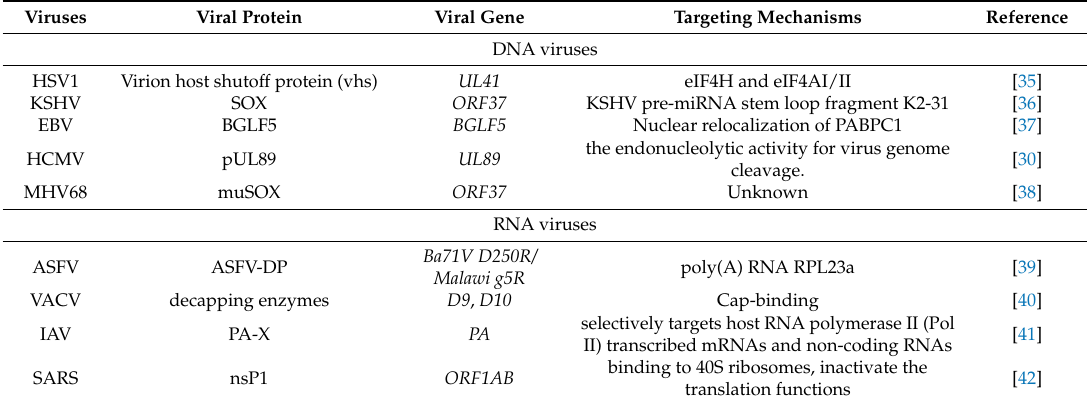
Table 2. Molecular mechanisms of viral enzymes directly destroy gene